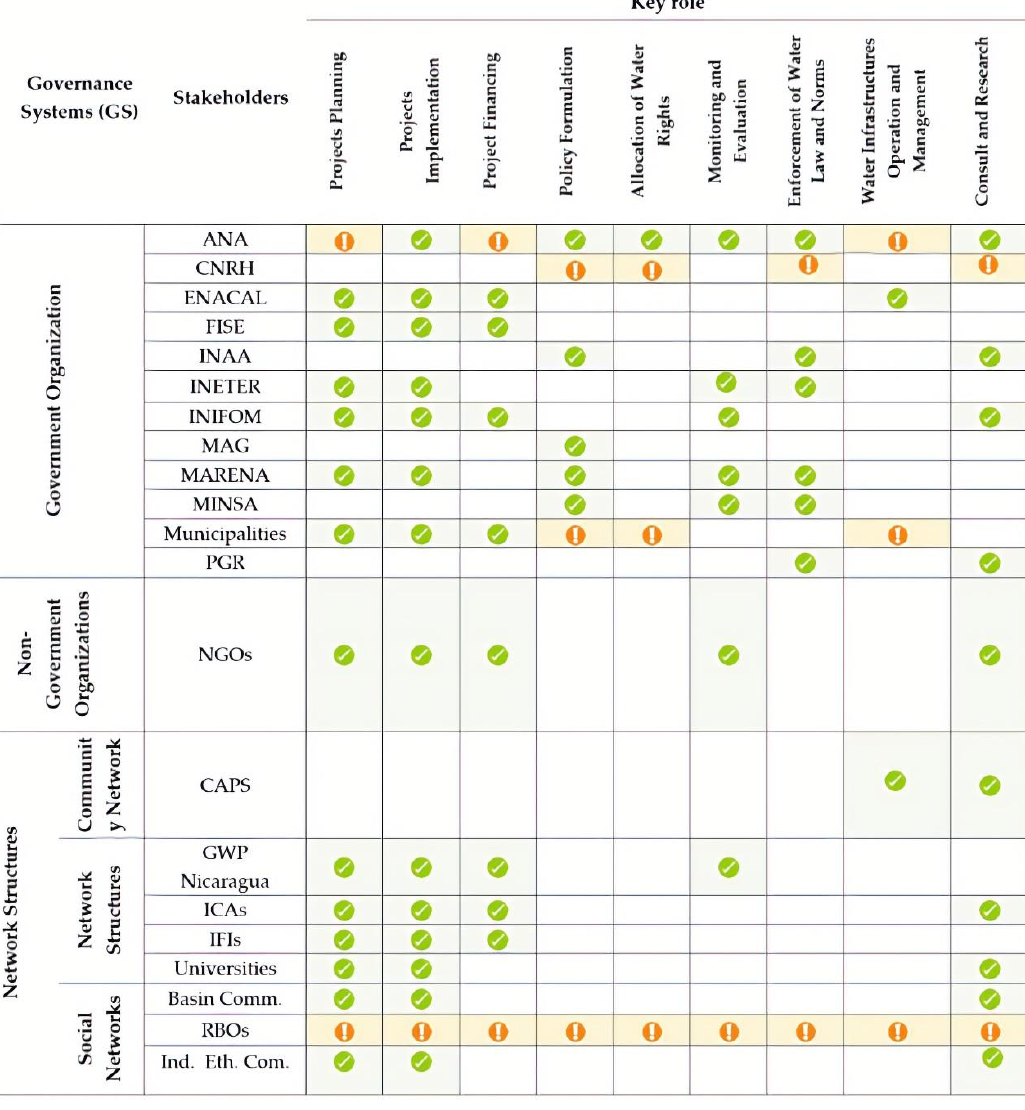
Figure 4. Stakeholder mapping of Nicaraguan multilevel water governance. FISE: Social Investment Fund; PGR: Attorney General of the Republic; Basin Comm: basin committees; RBOs: river basin organizations; Ind. Eth. Com.: indigenous and ethnic communities; GWP: Global Water Partnership, ICAs: international cooperation agencies. Source: authors’ own creation, based on Novo and Garrido [24].